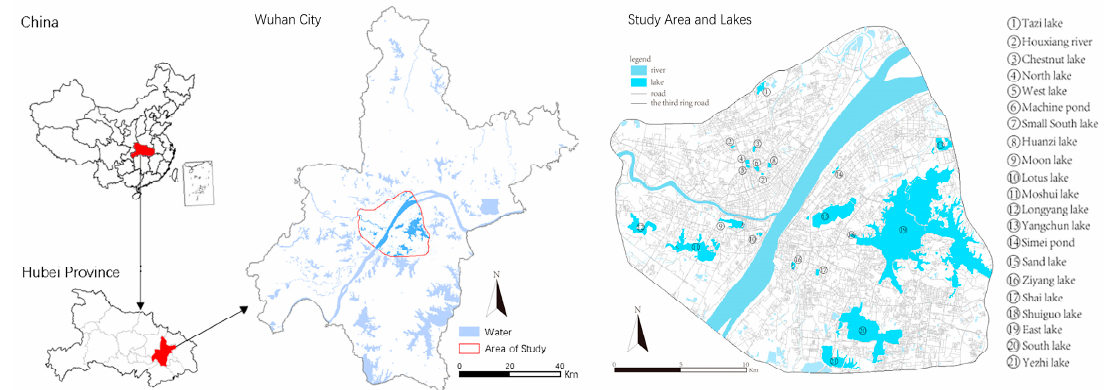
Figure 1. Location of Wuhan city and the study area lakes.